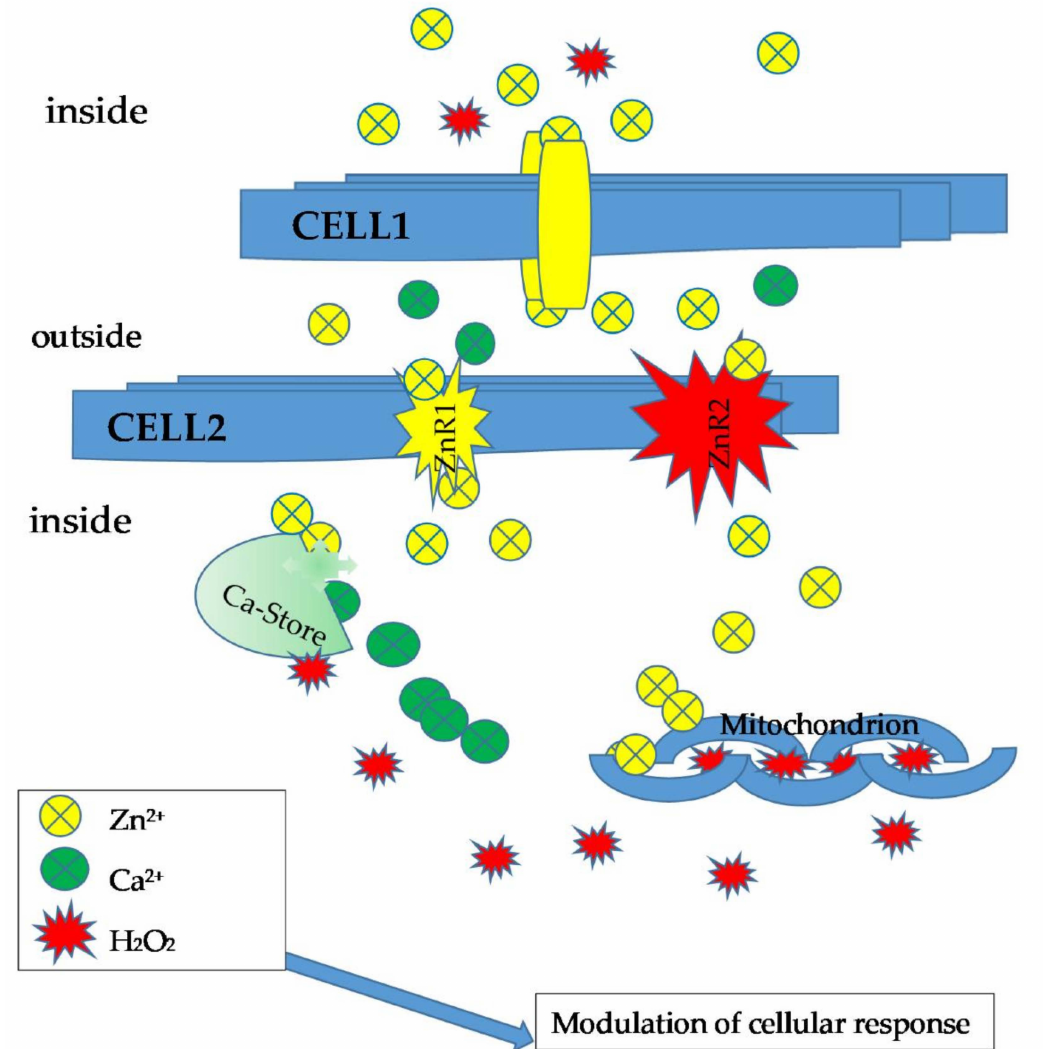
Figure 4. Diagram of extracellular Zn 2+ signaling pathways. Zn 2+ released into the extracellular space between cells can interact with receptors active on the surface of another cell through paracrine